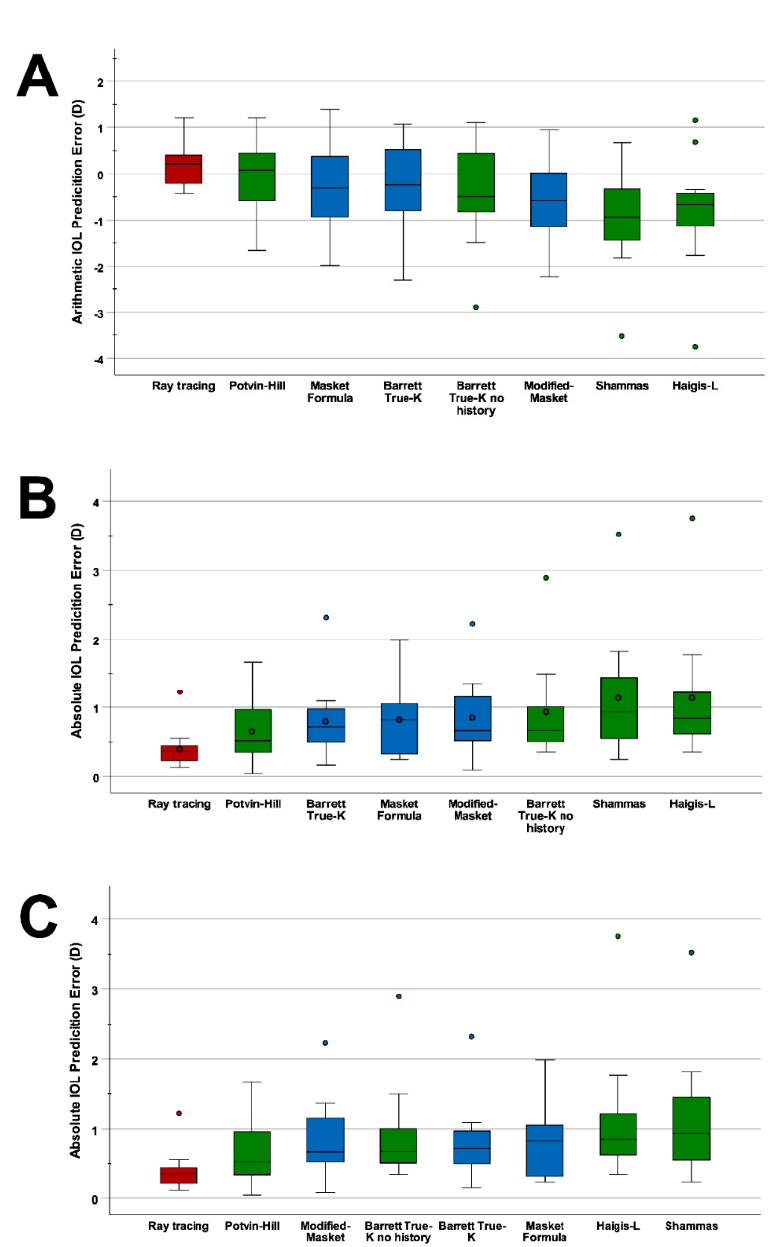
Figure 1. Prediction errors of IOL power calculation formulae. Blue boxplots show formulae that incorporate clinical history data and green boxplots show formulae that do not use any prior keratorefractive surgery data. The red boxplots represent ray tracing. ( A ) IOL power calculation formulae ranked from left to right according to their arithmetic prediction errors. ( B ) IOL power calculation formulae ranked from left to right according to their MAE. Circles demonstrate the respective MAE of each formula. ( C ) IOL power calculation formulae ranked from left to right according to their MedAE. (D, diopter).